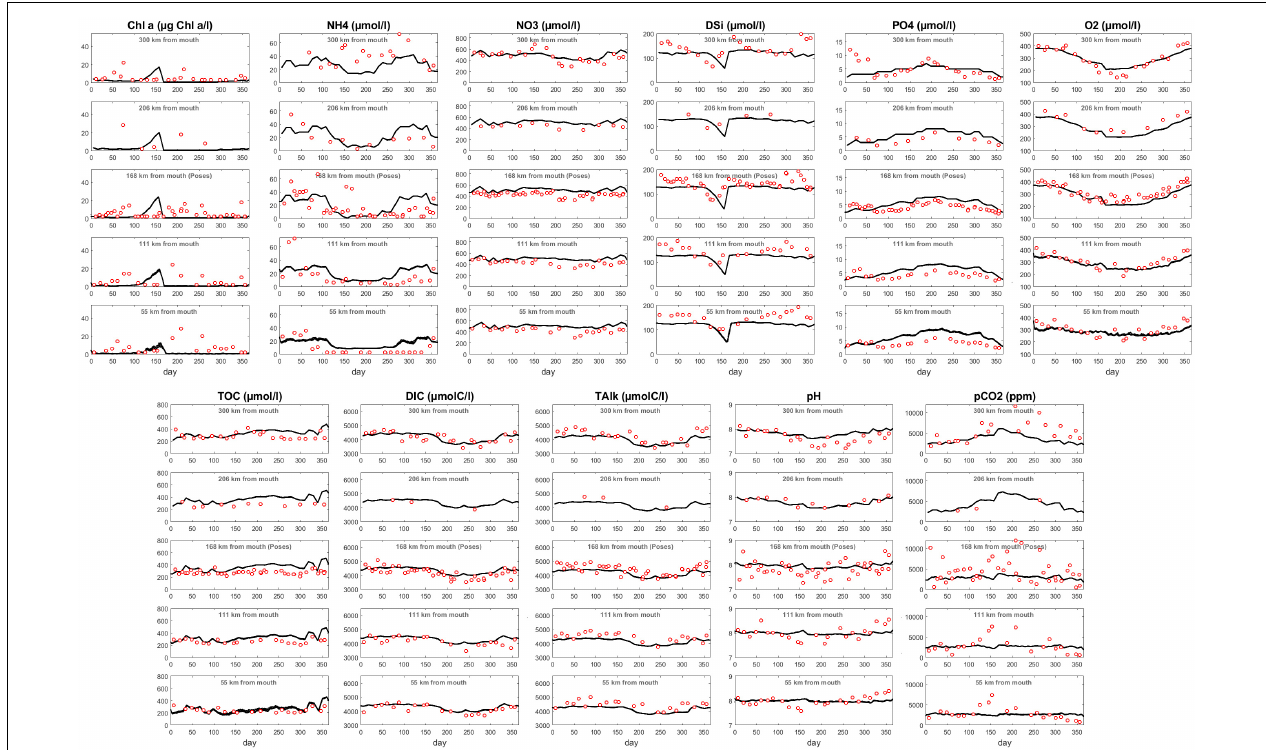
FIGURE 6 | Time series for Chl a, NH 4 , NO 3 , DSi, PO 4 , O 2 , TOC, DIC, TAlk, pH, and pCO 2 at five stations along the main axis of the Seine. Red dots correspond to measurements while black lines correspond to simulation